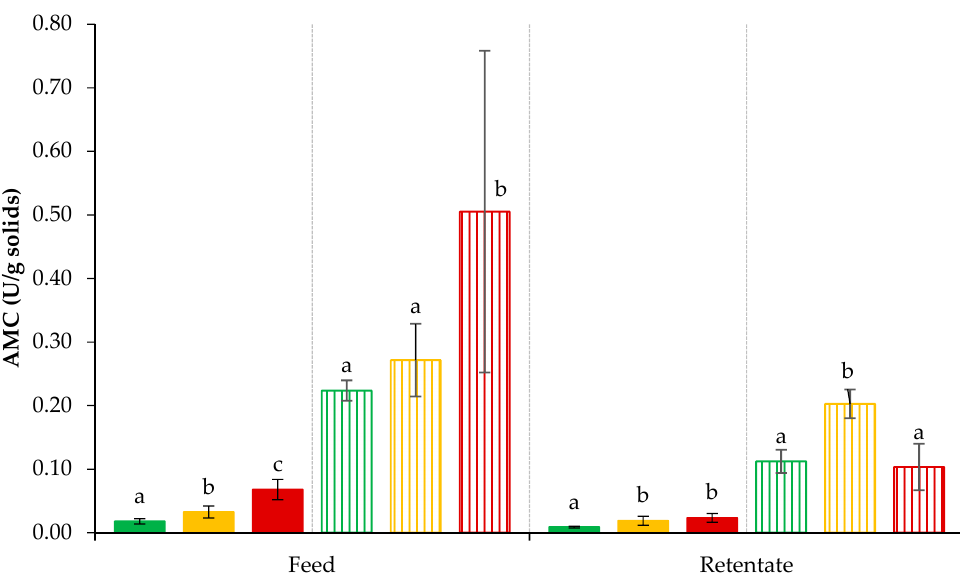
Figure 6. Innate plasmin (PL)- and plasminogen (PG)-derived plasmin activity in feed and UF retentate obtained at 5 ± 0.5, 20 ± 0.5, or 50 ± 0.5 °C. Bar colour represents PL at 5 °C ( ■ ), PL at 20 °C ( ■ ), PL at 50 °C ( ■ ), PG at 5 °C ( ║ ), PG at 20 °C ( ║ ), PG at 50 °C ( ║ ). Values are the raw mean ± standard deviation of at least duplicate analysis from triplicate runs at each test temperature. Different lower-case alphabet letters within feed PL and PG and retentate PL and PG indicate significant differences ( p < 0.05).